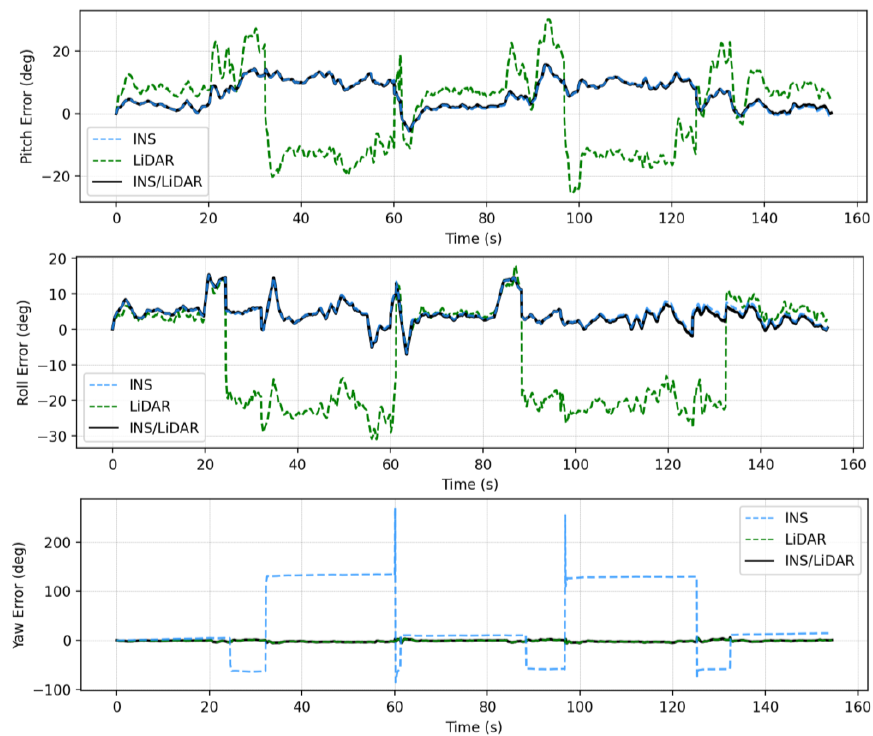
Figure 10. Complete GNSS signal outage: position errors (ENU).